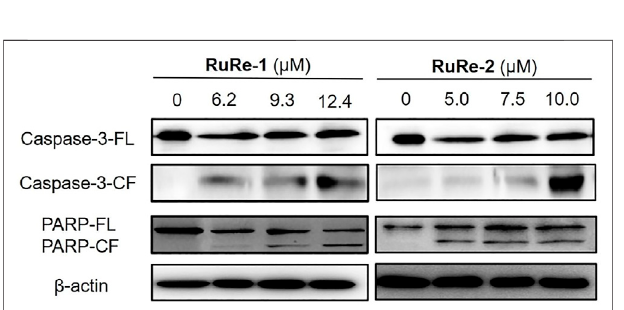
FIGURE 4 | Expression of apoptosis-related protein (caspase-3 and PARP) in HeLa cells treated with RuRe-1 and RuRe-2 for 24 h.